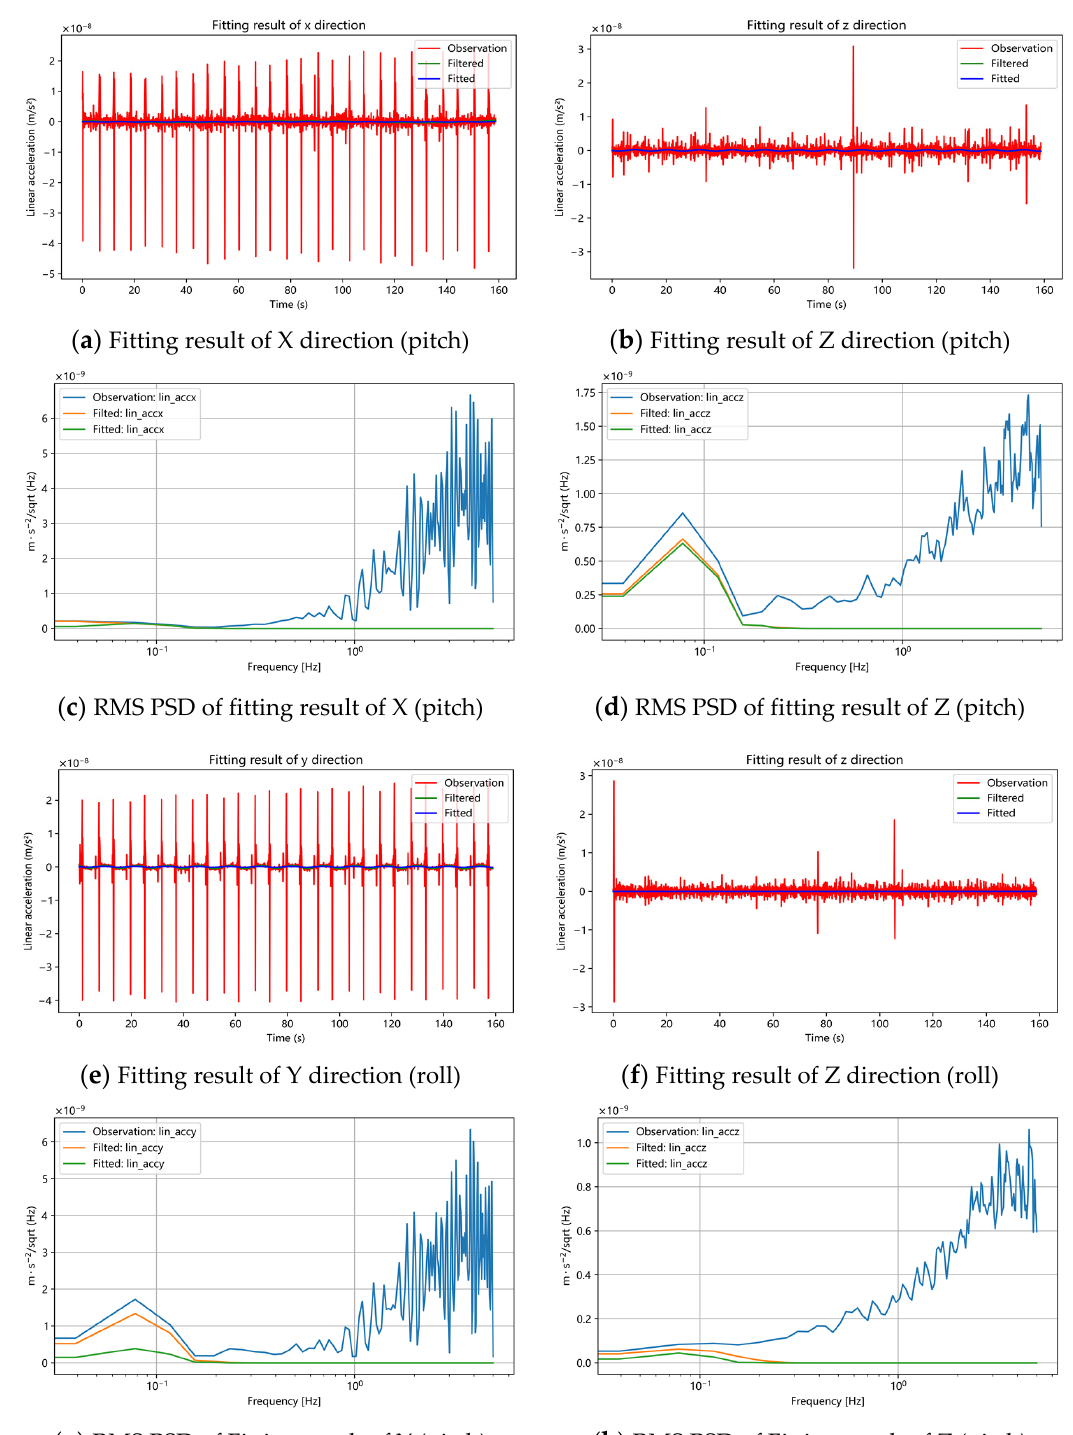
Figure 11. Fitting cures of linear acceleration in X ( a , c ) and Z ( b , d ) directions during the second (pitch) calibration maneuver and in Y ( e , g ) and Z ( f , h ) directions during the fourth (roll) calibration maneuver.